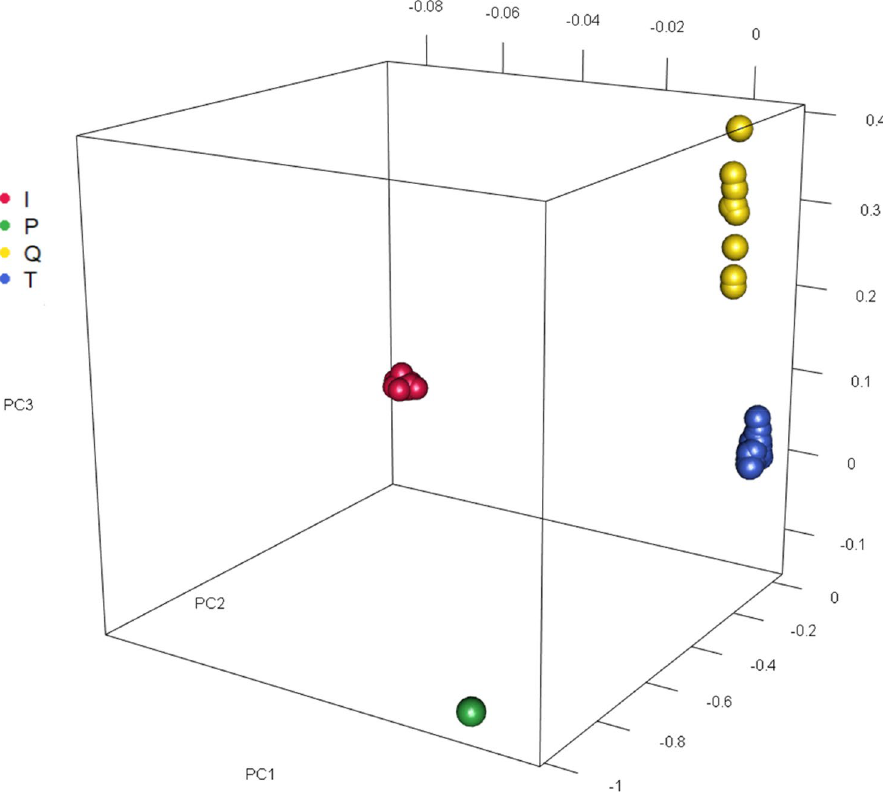
Figure 1. Principal components (PC1, 2, and 3) plot based on mitochondrial genomic relationship matrix showing the grouping of I, P, Q and T major